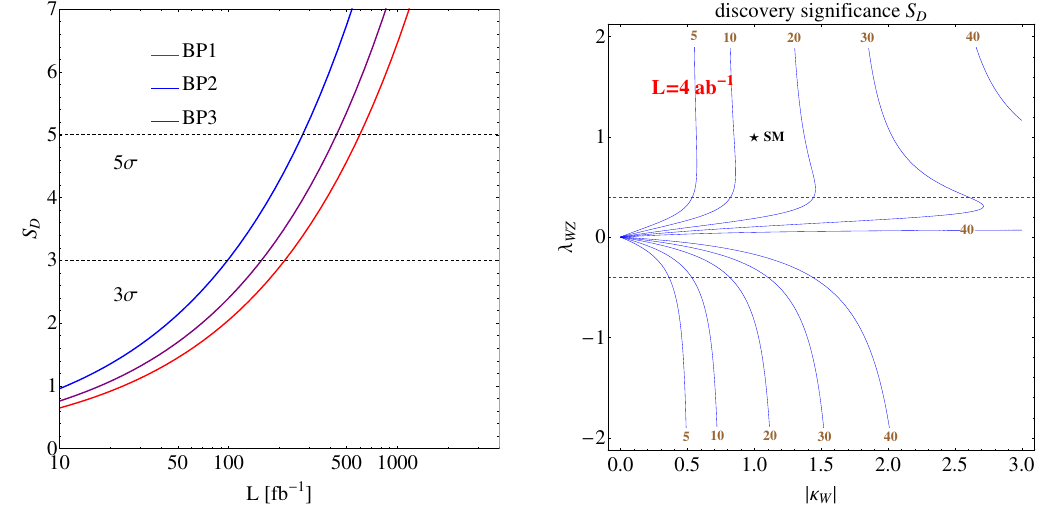
Figure 3 . Discovery potential of the e + e (cid:0) GeV ILC with the beam polarization P ( e (cid:0) ; e + ) = ( three benchmark scenarios de(cid:12)ned in the main text as a function of the integrated luminosity. Right: contours of signal signi(cid:12)cance in the The red dashed lines correspond to (cid:21) WZ =